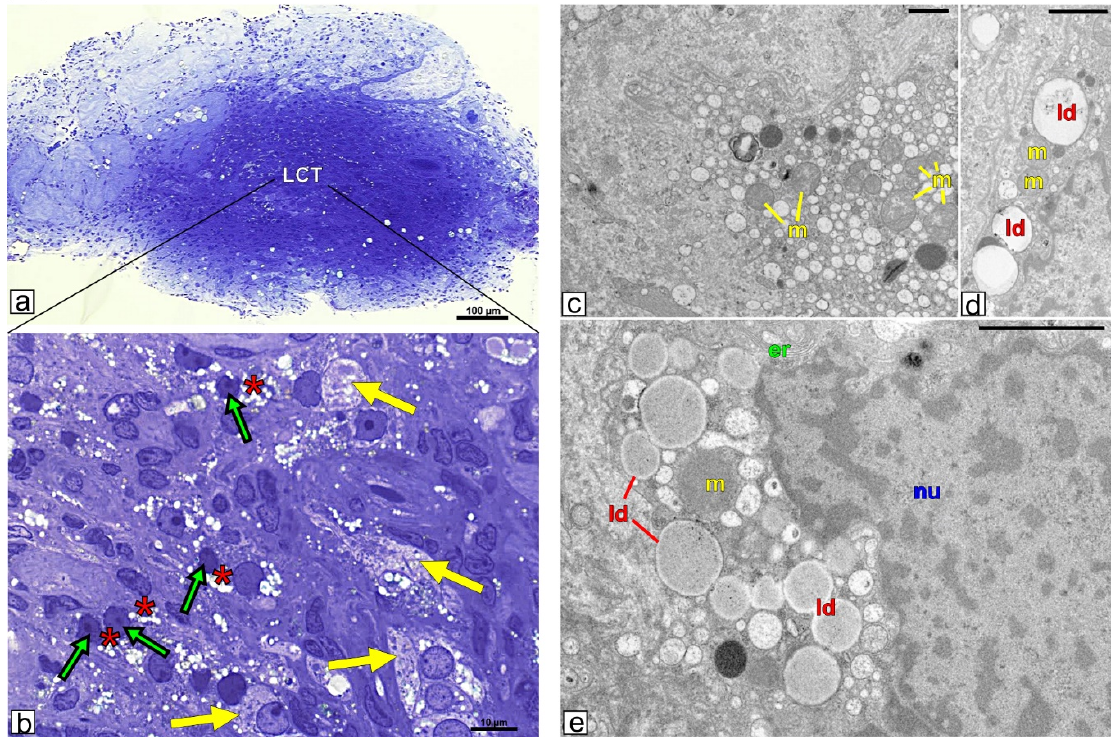
Figure 1. Ultrastructure of Leydig cell tumor . Representative microphotographs of semi-thin sections ( a and b higher magnification) and ultrathin ( c – e ) of Leydig cell tumor. ( a , b ) Sections of testicular tissue of obese patient as representative for both obese and no-obese patients. Bars represent 1 μ m. (c – e ) Sections of Leydig cell of obese patient ( c ) and non-obese ( d , e ) patient. Analysis was performed on testicular blocks from at least three experimental groups. ( a , b ) green arrows depict Leydig cells (different morphological types); red arrows depict adipocyte-resembling cells; asterisks indicate lipid droplets in Leydig cells. (c – e) ld-lipid droplets; m-mitochondria; n -nucleus; er-rough endoplasmic reticulum.